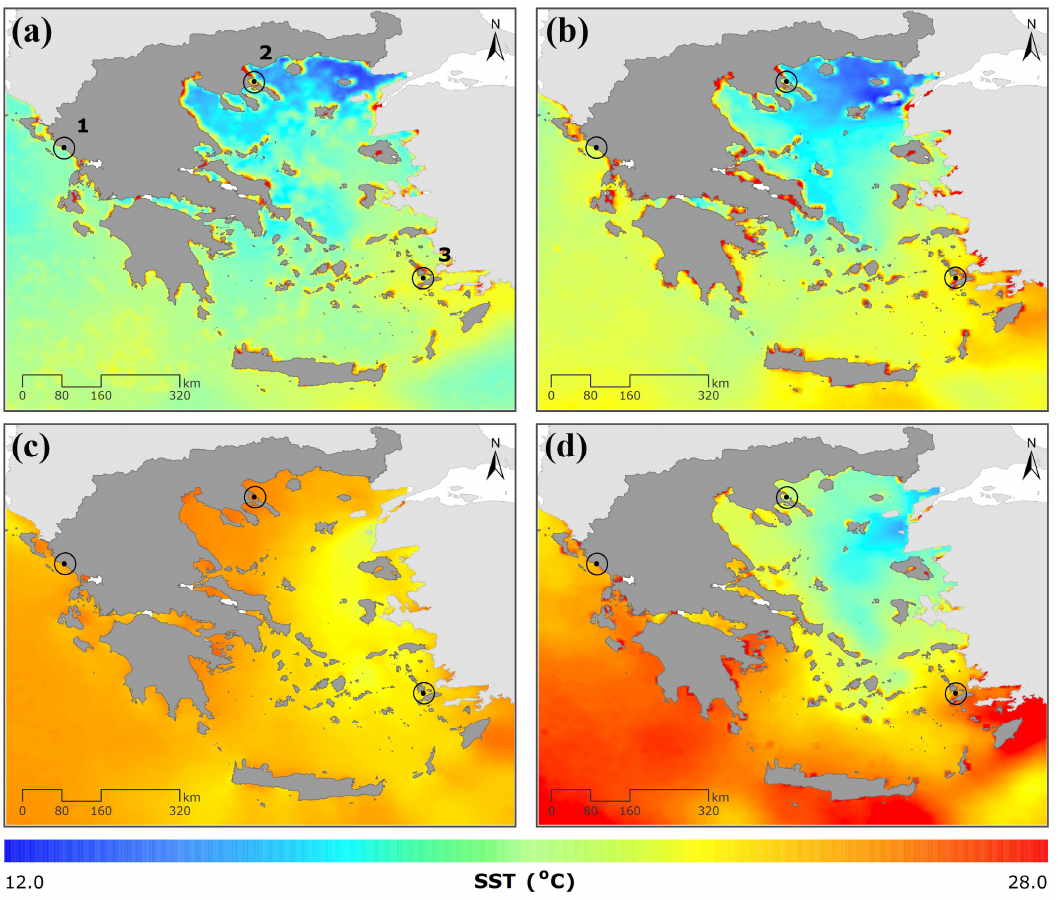
Figure 1. Satellite-derived sea surface temperature seasonal mean (SST) (2003–2014) and location of the artificial reefs. ( a ) Winter; ( b ) Spring; ( c ) Summer; ( d ) Autumn; 1: Preveza; 2: Ierissos; 3: Kalymnos.